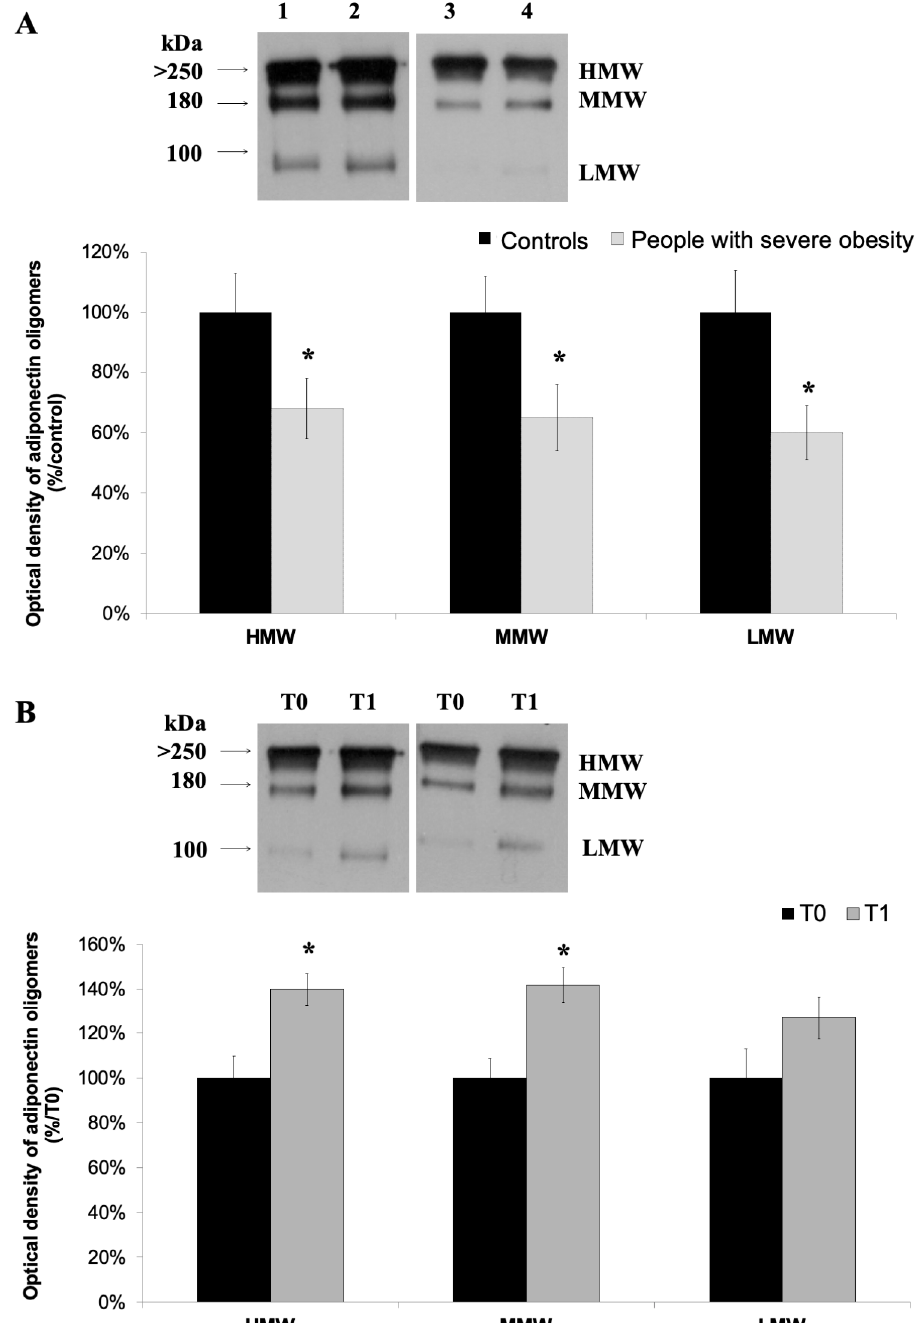
Figure 1. Western blotting of adiponectin and its oligomerization state in the serum of controls and people with severe obesity ( A ) at baseline, and in people with severe obesity at baseline and the end of a 4-week Hypocaloric diet and Physical exercise Program (HPP) ( B ). ( A ) Representative blot images showing di ff erent adiponectin oligomers (HMW, MMW, and LMW) in controls (lanes 1–2) and people with severe obesity (lanes 3–4). ( B ) Representative blots images of HMW, MMW, and LMW oligomers in two people with severe obesity, at T0 and T1. The graphic representation of the pixel analysis was performed using the ImageJ software, and the values are reported as mean +/ - S.D. of two independent experiments performed in duplicate. The statistical significance was established at * p < 0.5.